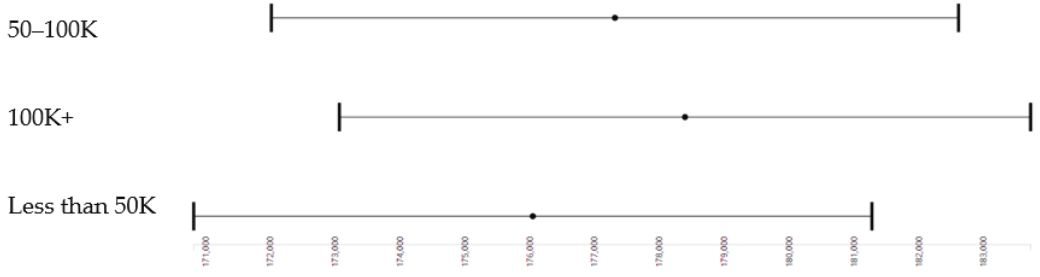
Figure 1. E ff ects of household income categories on the whole-brain cortical surface area in the whole sample (race, ethnicity, age, sex, parental education, family, and site are controlled).